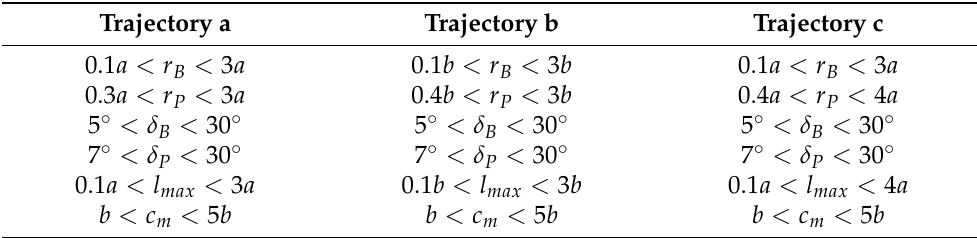
Table 1. Upper and lower boundaries of the decision variables for the dimensional